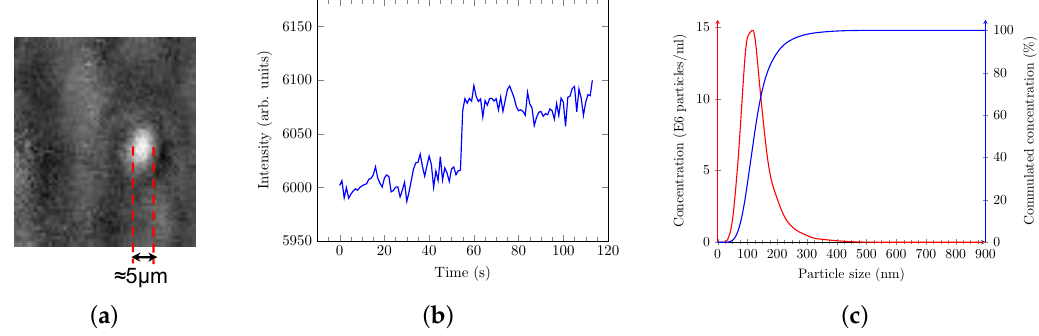
Figure 3. Typical processed image of a microvesicle binding onto the functionalized sensor surface is represented by a bright spot on a grey background ( a ). Bright pixels grouped in one spot stand for one binding event. Time-course changes of the light intensity in such a group of pixels are described by a vertical jump of intensity, in a moment of particle binding, at a new oscillation level and stabilization there ( b ). In parallel, we also measured the samples containing microvesicles derived from SH-SY5Y cells using LM10 device. The results of one of such measurements are presented on panel ( c ). The uniqueness of a significant particle size peak and similarity of the measured particle size with previously published results indicate that samples measured by our PAMONO-sensor consist predominantly of individual microvesicles. ( a ) sensor image data; ( b ) intensity step over time; and ( c ) LM10